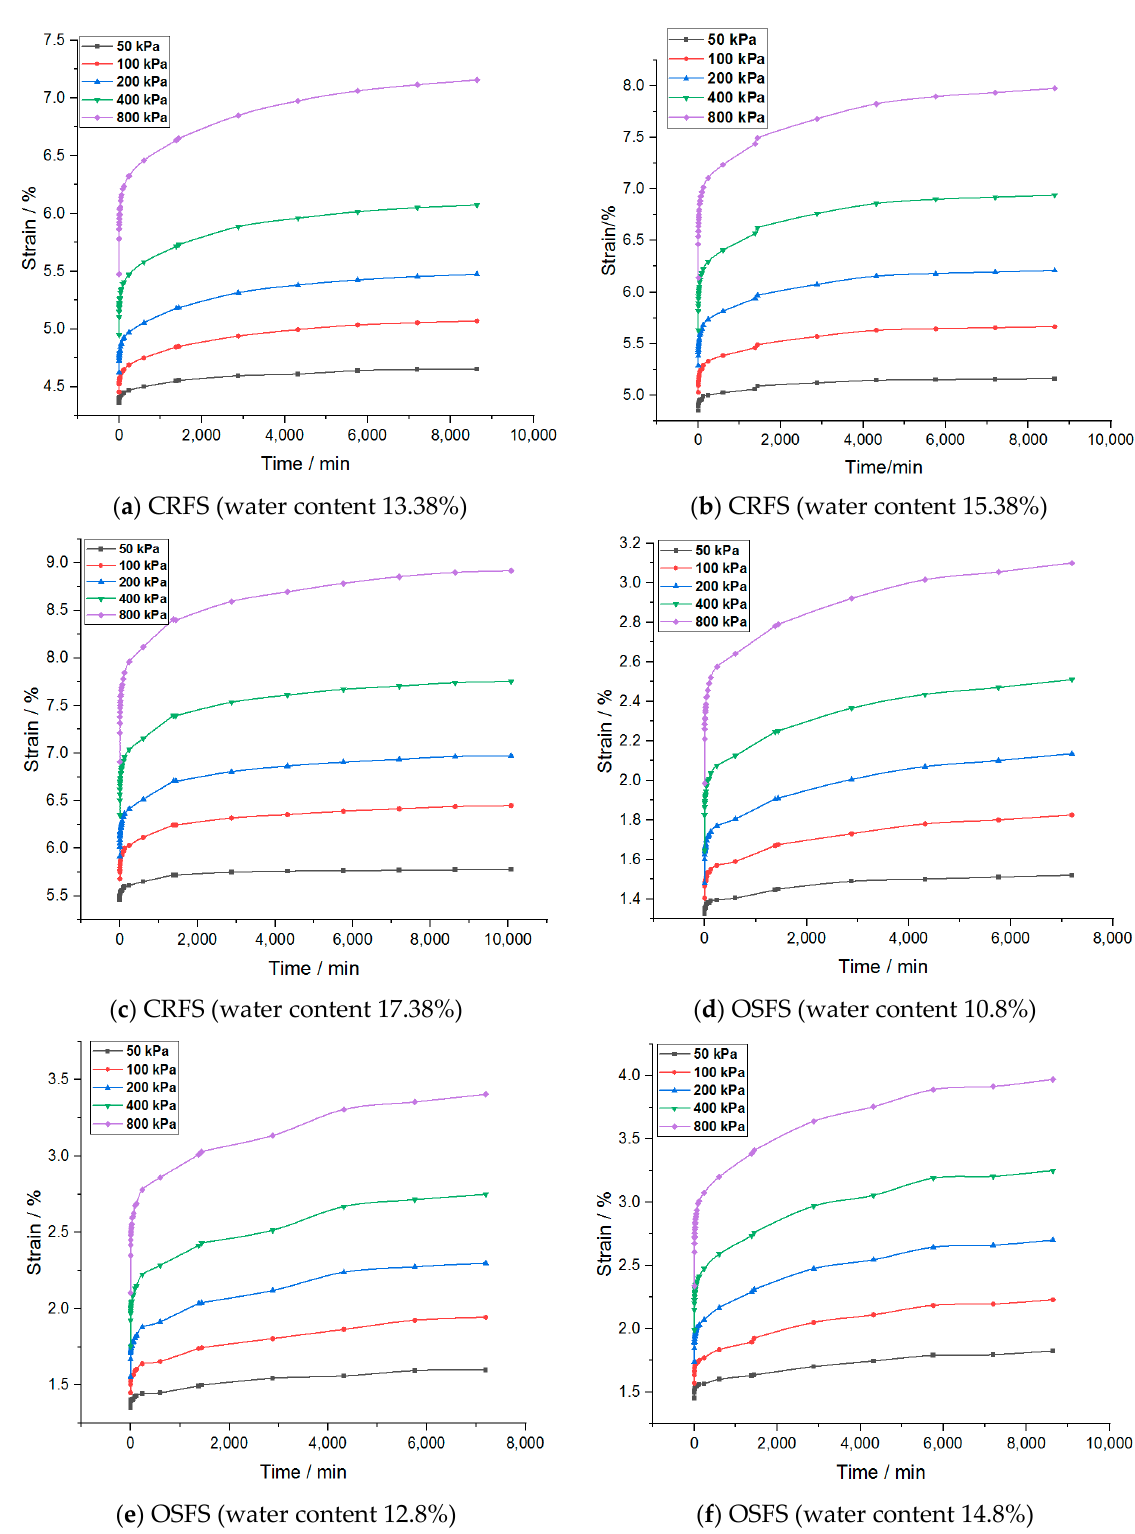
Figure 5. Strain–time curves of samples with different water content after process.